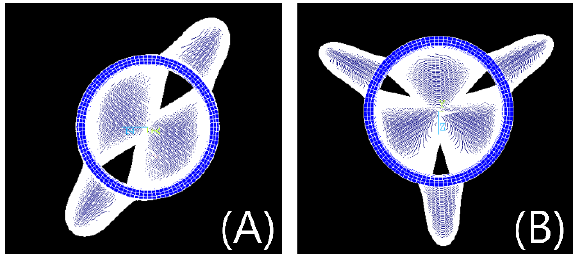
Figure 3. Comparison of the buckling modes. Top views of the specimens: ( A ) Tube 1-03 and ( B ) Tube 3-03.